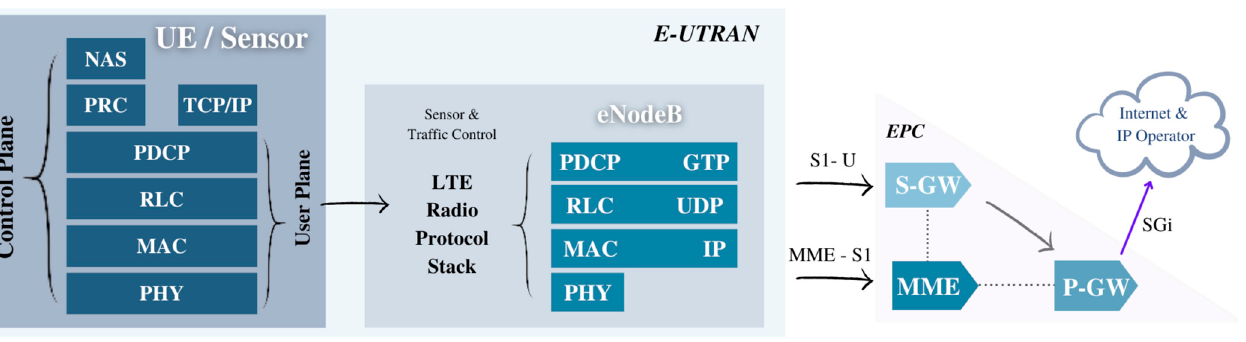
Figure 7. User plane CIoT EPS 3GPP LTE protocol stack from the sensor to eNodeB. Communication interfaces from eNodeB to the Internet services.